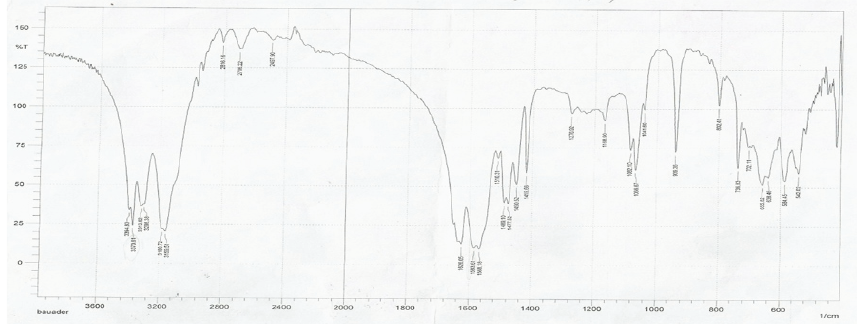
Figure 2: The IR spectra of the ligand metformin (L 2 ).